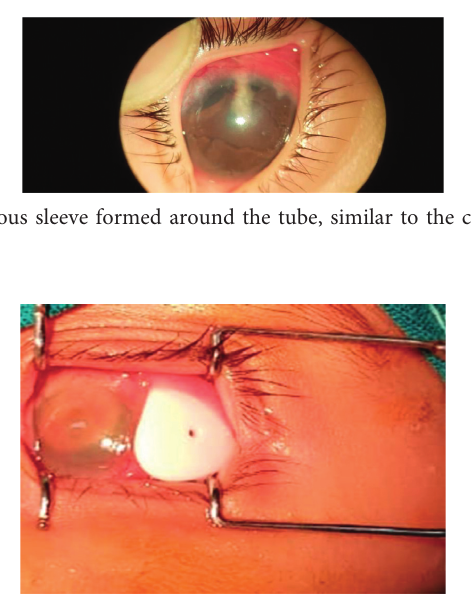
Figure 3: Extrusion of the valve due to severe erosive conjunctivitis.